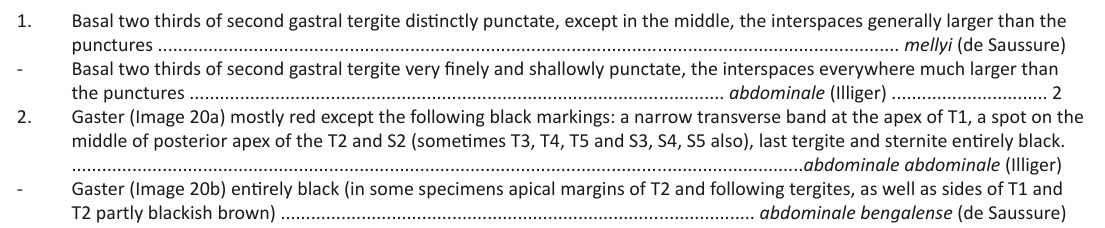
spot in the middle of its apical margin, the remaining segments usually orange-red except last segment black, gastral sternites usually orange-red with varying degrees of black colour except last segment entirely black. Brown colouration as follows: ventral side of antenna and tarsal segments (sometimes black). Wings dark fuscous with purple reflections. Size (H+M+T1+T2): 12–14.5 mm. Male: Clypeus more elongate and the apex between two teeth more deeply emarginated than female; antenna with the last segment hooked apically and almost reaches the apex of tenth antennal segment in curved position; apical tip of aedeagus rounded, parallel spines elongate without hairs. Colour description: Colour pattern is almost the same as that of the female except clypeus almost entirely yellow with the lateral and apical margins black and scape in front yellow.